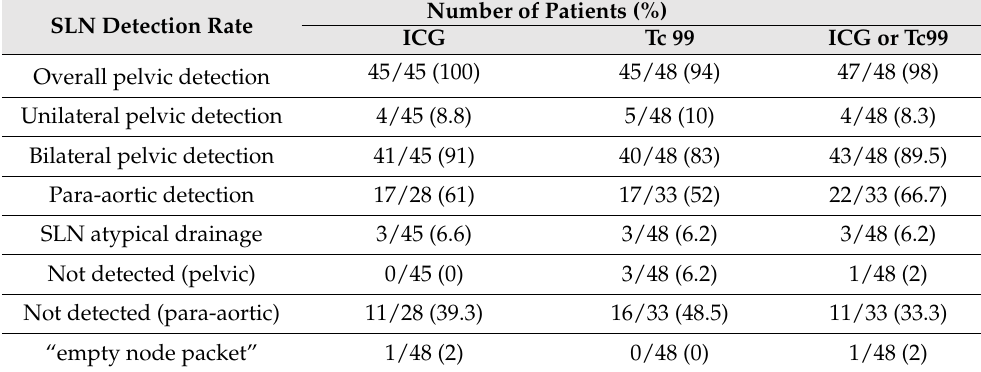
Table 4. Sentinel lymph nodes’ detection